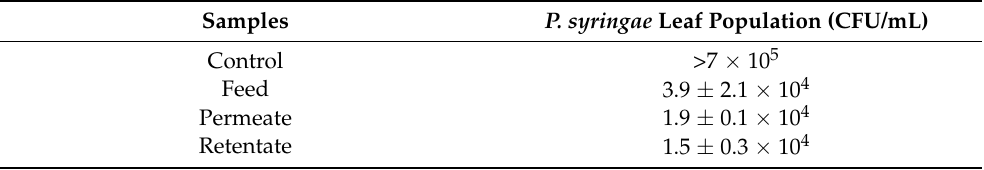
Table 2. Biological activity of the fractions collected after filtration by 5 kDa PES membranes.